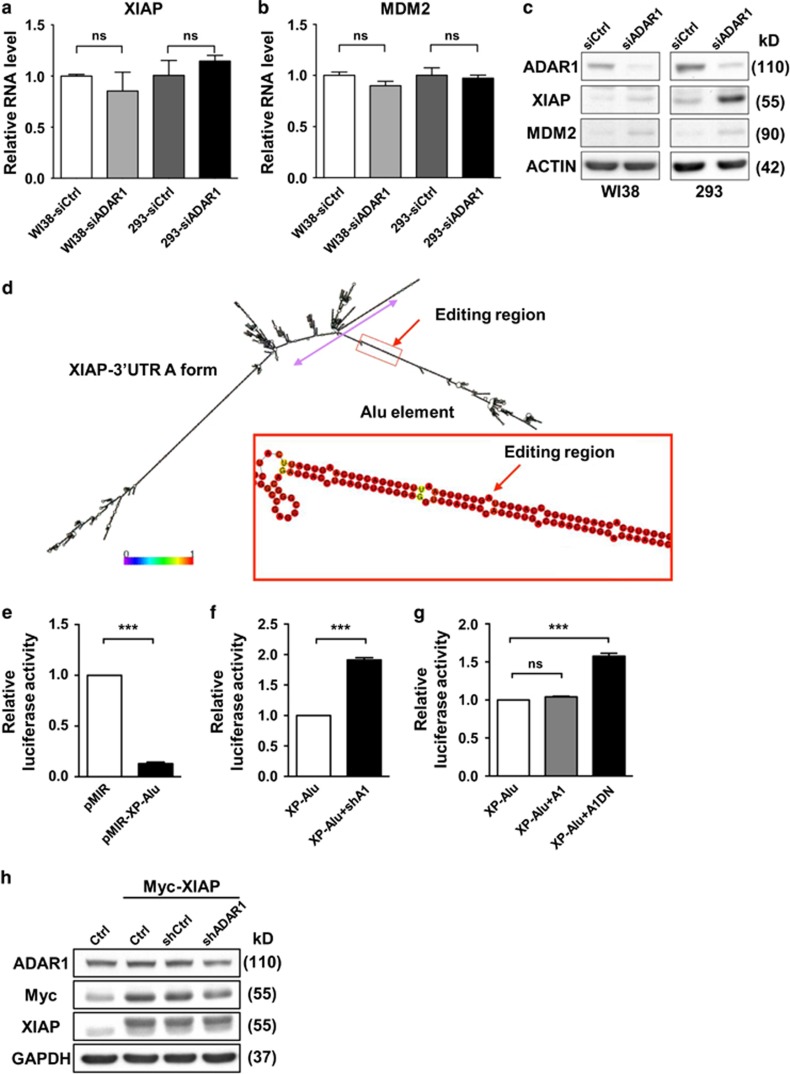
ADAR1 targets the 3′ UTR of XIAP and MDM2 for post-transcriptional expression regulation. (a and b) Following transfection with control (siCtrl) or ADAR1-targeting (siADAR1) siRNAs, total RNAs were isolated from WI38 or 293 cells and subjected to real-time RT-PCR to quantify the expression levels of XIAP (a) and MDM2 (b) mRNA. Relative RNA levels (to GAPDH) were normalized to the control group, and shown as mean±S.D. (c) WI38 and 293 cells were transfected with siRNAs targeting ADAR1 (siADAR1) or control siRNAs (siCtrl) prior to western blot analysis for XIAP, MDM2 and ADAR1 expression. ACTIN serves as the internal control. (d) Putative secondary structure of the XIAP 3′ UTR, as predicted by the RNAfold Webserver. Hyperediting region is denoted by a red arrow, with a magnified view of the boxed area shown below. Colors of the nucleotides correspond to base-pair probabilities, based on the color scale bar. Sequences corresponding to this particular stem loop, with the embedded IRAlus, were subcloned into the 3′ UTR reporter plasmid. (e) 3′ UTR reporter assay was conducted on cells transfected with control empty vector (pMIR vector) or the construct containing IRAlus derived from XIAP 3′ UTR (pMIR-XP-Alu). Luciferase activity was detected after 48 h and normalized to the co-expressed β-gal levels, with controls being represented as 1. (f and g) 3′ UTR reporter assay was done as in (e), except with the additional co-transfection of expression plasmids for ADAR1-targeting shRNAs (shA1), the wild-type form of ADAR1 (A1), or the dominant-negative mutant (A1DN). (h) The construct encoding a 3′ UTR-free Myc-tagged XIAP and control vector (Ctrl) were ectopically co-expressed with pSUPER vector (shCtrl) or ADAR1-targeting (shADAR1) shRNAs, as indicated. Protein expression of XIAP, Myc and ADAR1 in different transfectants of HeLa cells was subsequently detected by immunoblotting, with GAPDH as the loading control (for statistical analyses shown in this figure: NS, not significant or P>0.05; *P<0.05; **P<0.01; ***P<0.001)